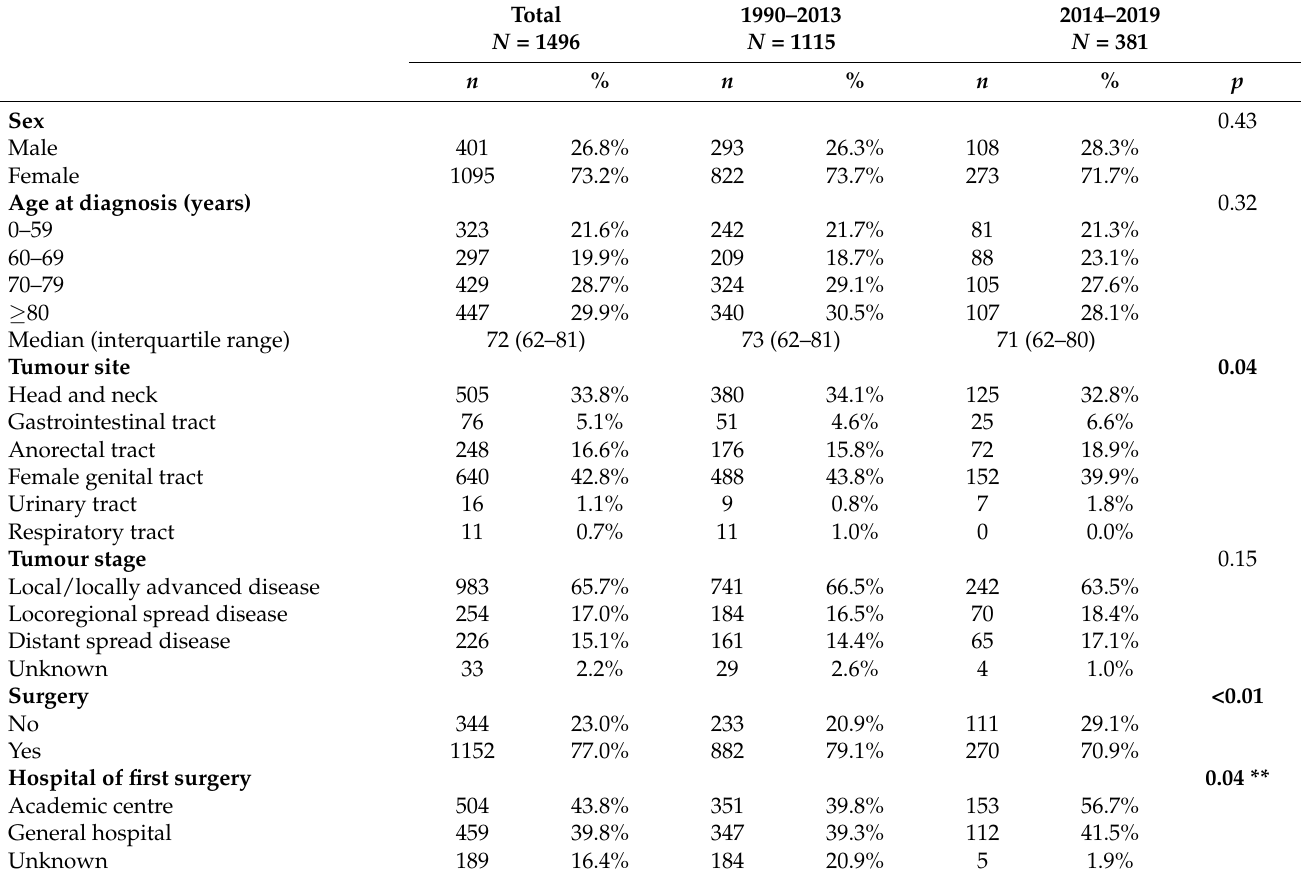
Table 1. Baseline, tumour, and treatment-related characteristics of patients with mucosal melanoma in the